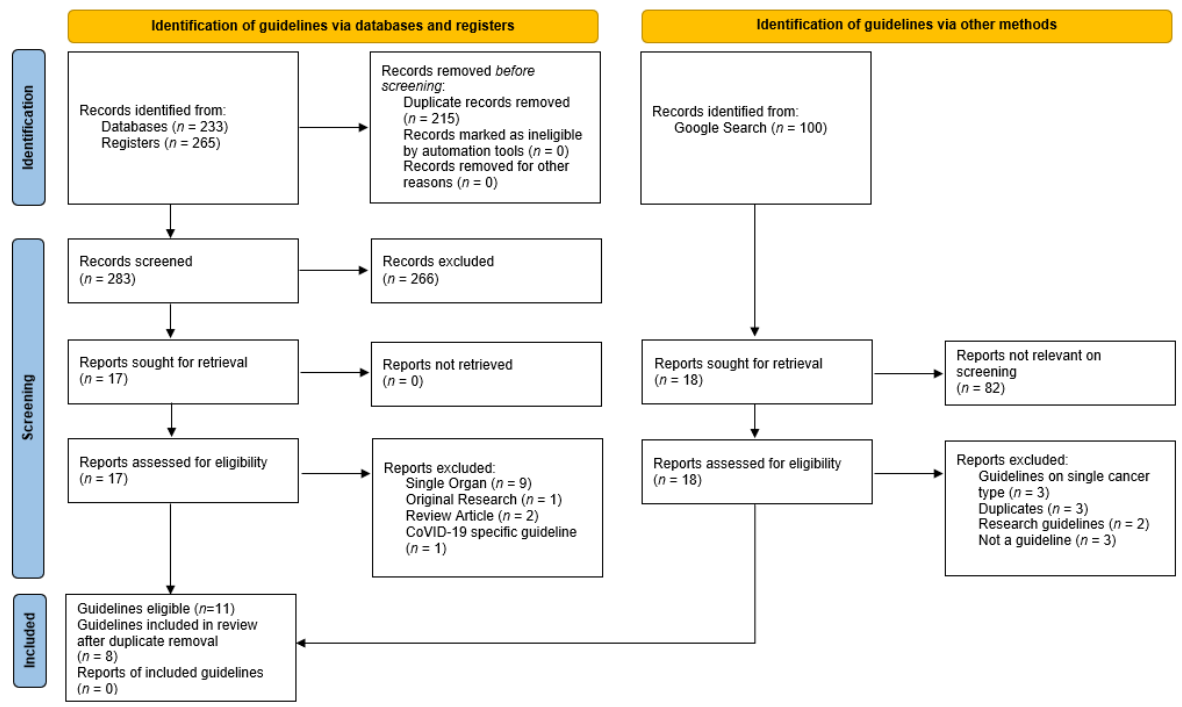
Figure 1. Flow chart database search demonstrating the records identified, screened, and included with reasons for exclusion identified.